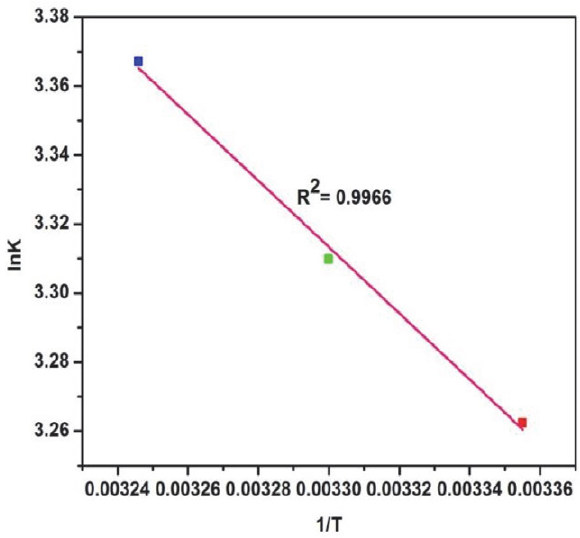
Fig. 5. Van’t Hoff plot of As(V) adsorption at different